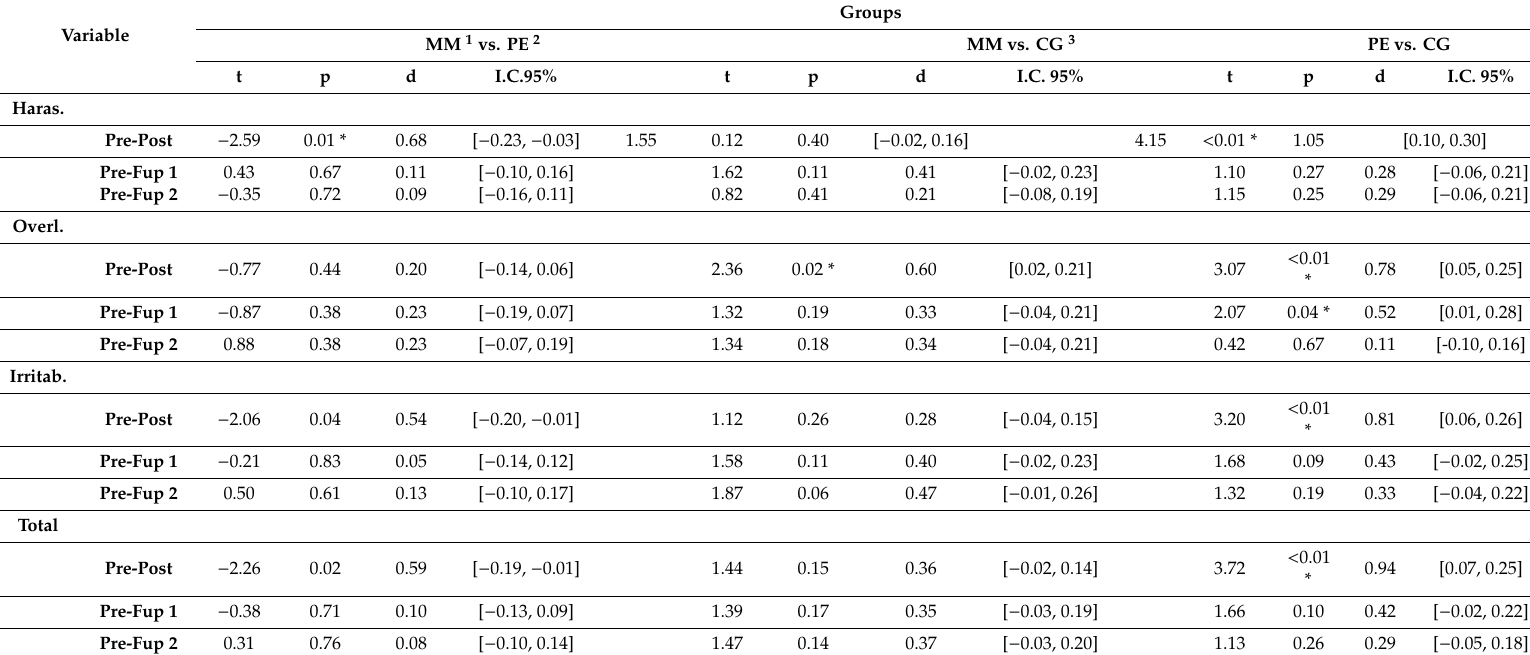
Table 3. Analysis of simple e ff ects—interaction factor